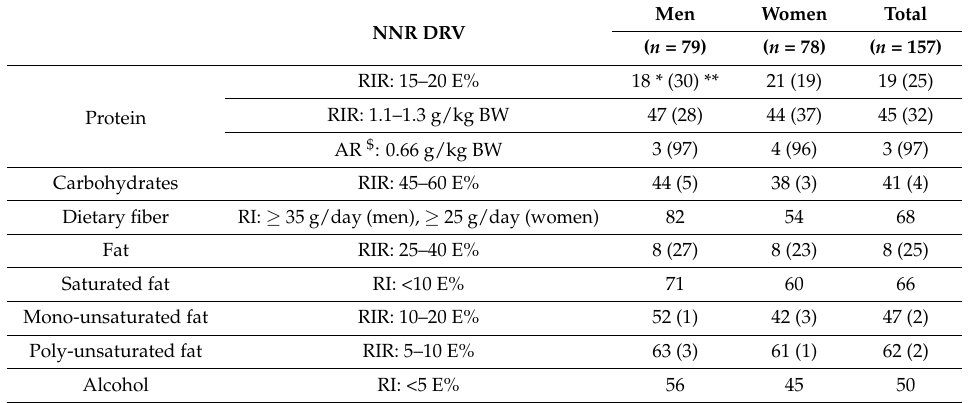
Table 3. Percentage of study population below (and above) the Nordic Nutritional Recommendations (NNR) Dietary Reference Values (DRV) for different macronutrients, dietary fiber and alcohol.